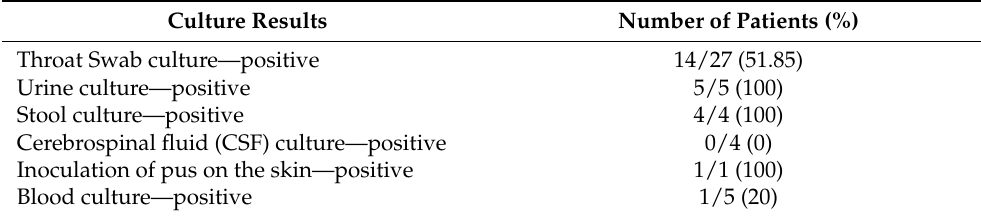
Table 4. Culture results to find the causes of febrile neutropenia.